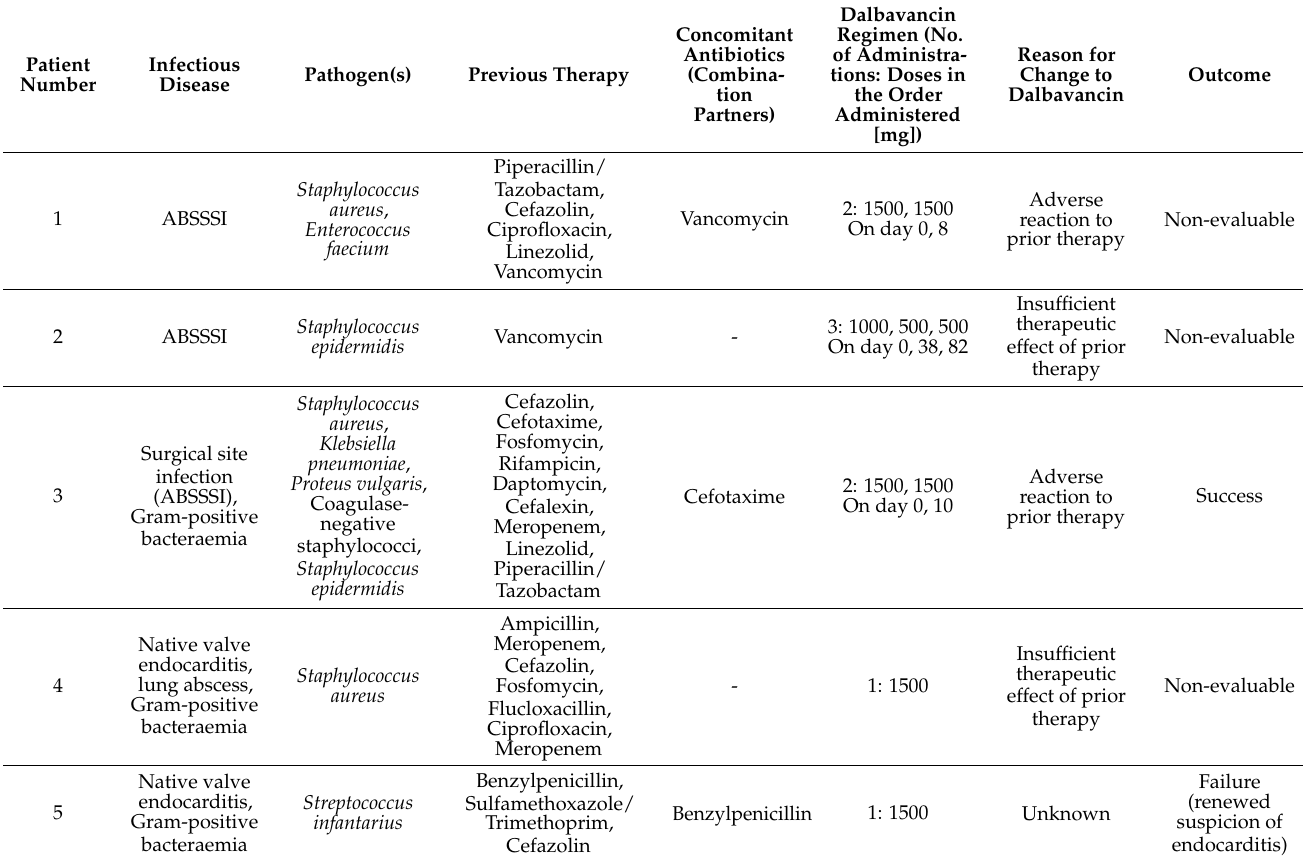
Table 2. Per-patient data on patients, disease, therapy, and